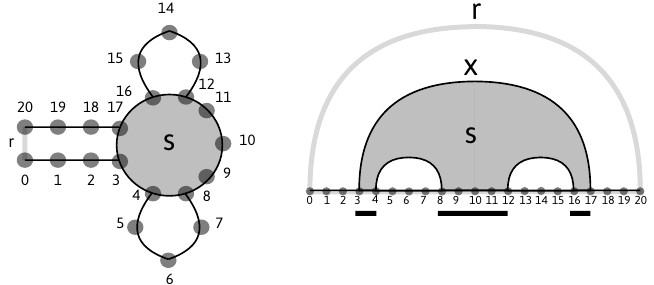
Figure 1. Left: a planar RNA secondary structure with a closing base pair r = ( 0,20 ) . Right: its diagram representation on the set of vertices [ 19 ] with two additional vertices, 0 and 20, forming the rainbow r = ( 0,20 ) , the loop s = [ 3,4 ] ∪ [ 8,12 ] ∪ [ 16,17 ] (shaded), and the corresponding intervals (underlined). The arc x = ( 3,17 ) is the maximal arc of s , α s = x